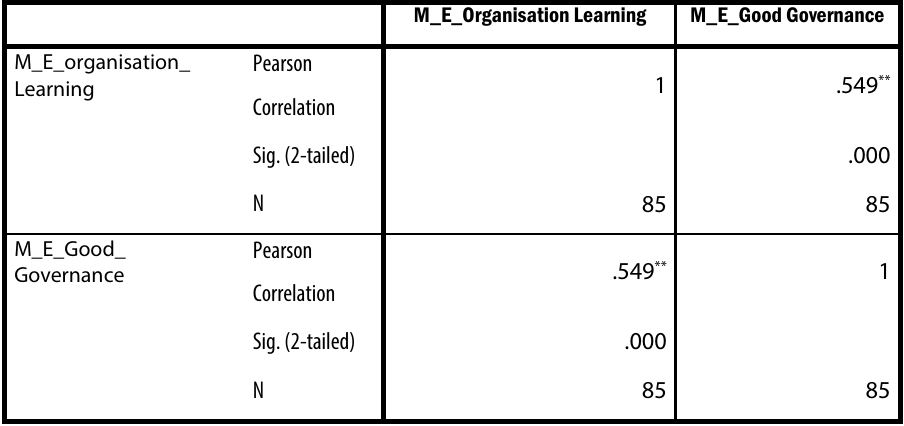
Table: 7: Correlation of M&E Organization Learning and Good Governance M_E_Organisation Learning M_E_Good Governance Pearson M_E_organisation_ 1 .549 ** Learning Correlation Sig. (2-tailed) .000 N 85 85 Pearson M_E_Good_ .549 ** 1 Governance Correlation Sig. (2-tailed) .000 N 85